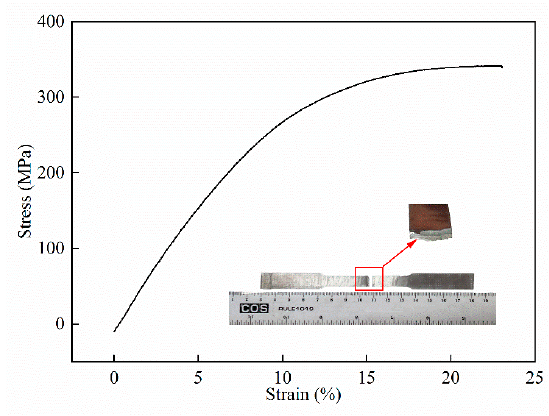
Figure 7. Typical stress-strain curves obtained by tensile tests.